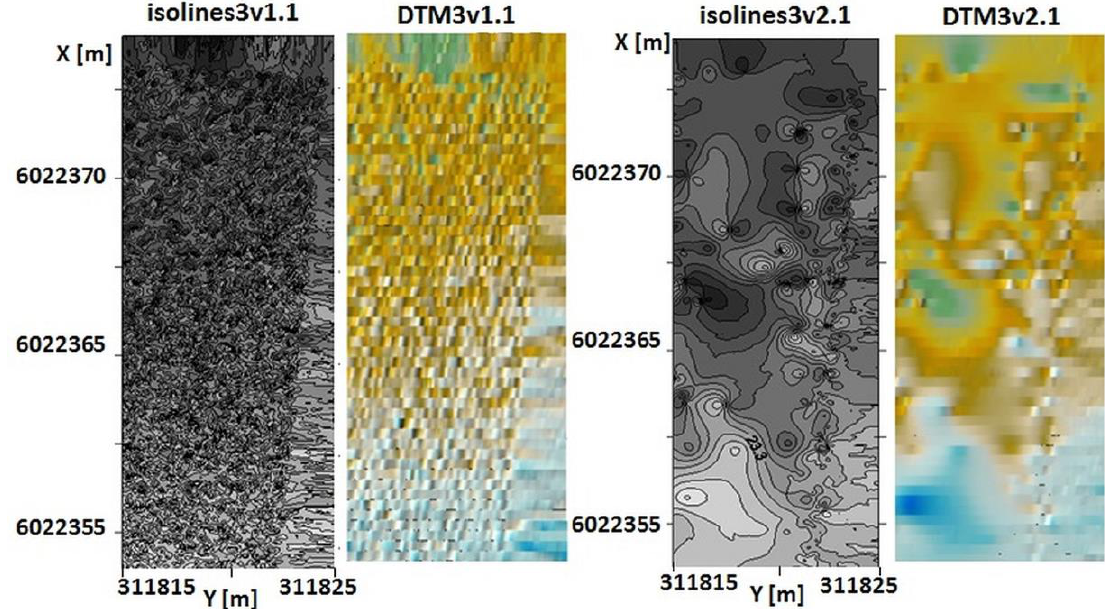
Figure 10. Isolines2v1.1 and DTM2v1.1, and isolines2v2.1 and DTM2v2.1 generated for strip 2 (p 2 ) by methodologies v1.1 and v2.1, respectively.